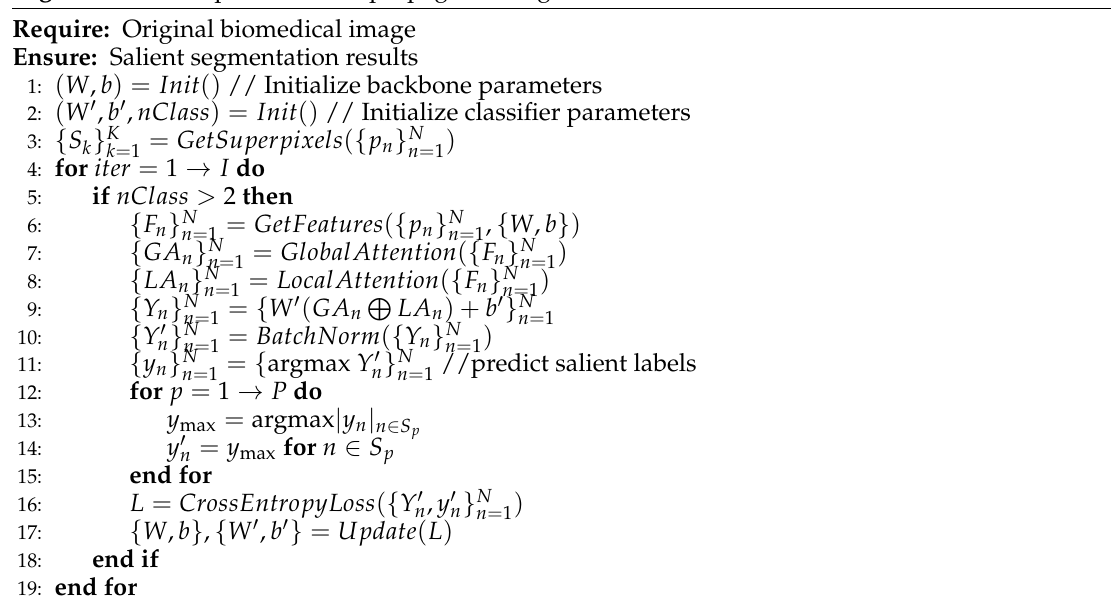
Algorithm 1 Unsupervised Backpropagation